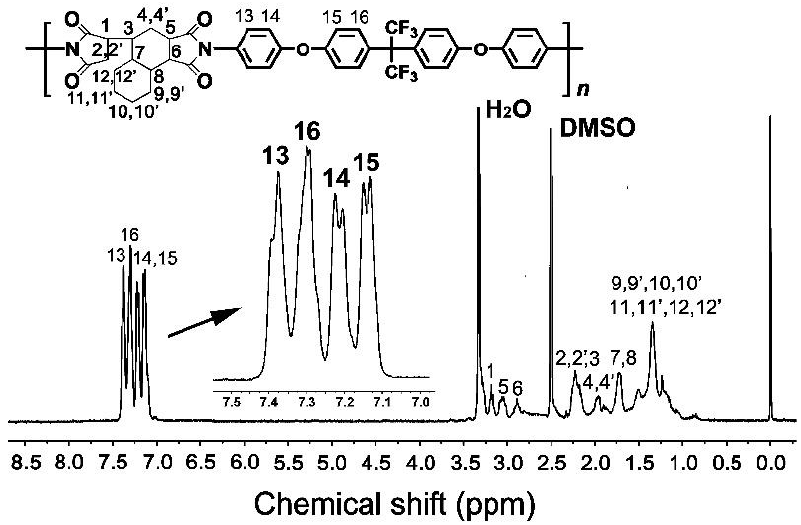
Figure 4. 1 H NMR spectrum of the PI(HTDA-BDAF) resin (NMR solvent: DMSO- d 6 ). A series of PI (HTDA-BDAF) NFMs were fabricated by the electrospinning proce-